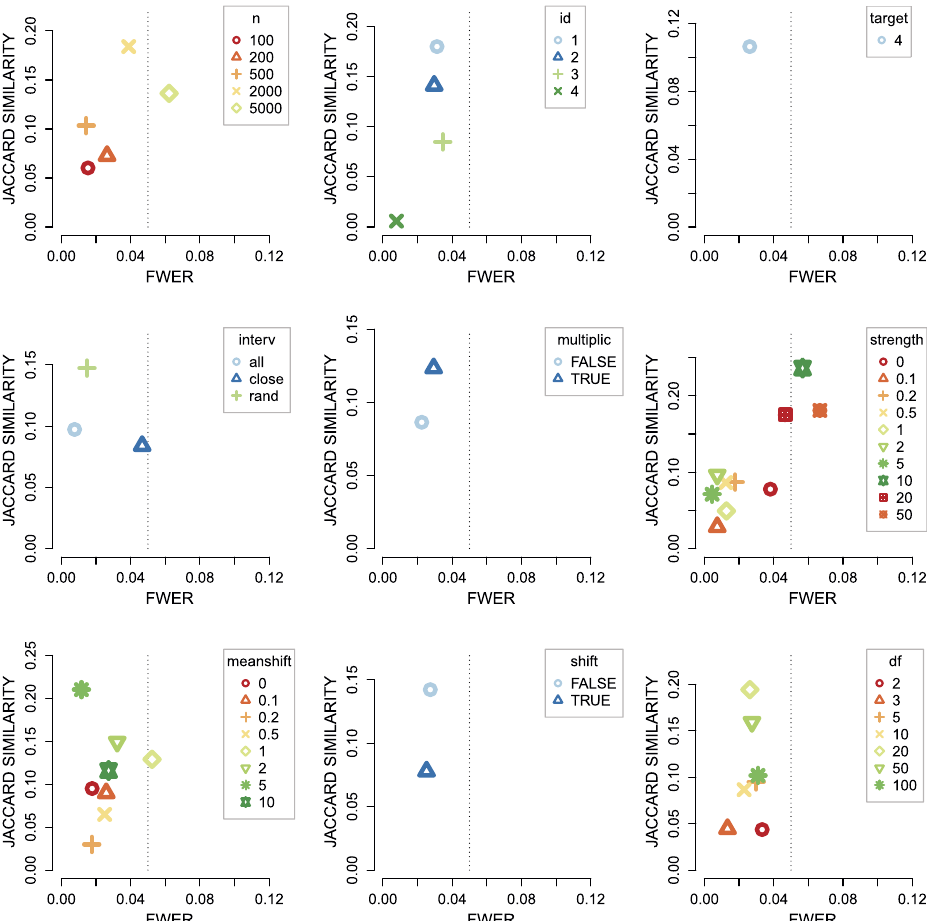
Figure 12: Average Jaccard similarity over the conditional independence tests (A)–(F) (y-axis) against average FWER (x-axis) when estimating the parents of variable 4. The figure is otherwise generated analogously to Figure